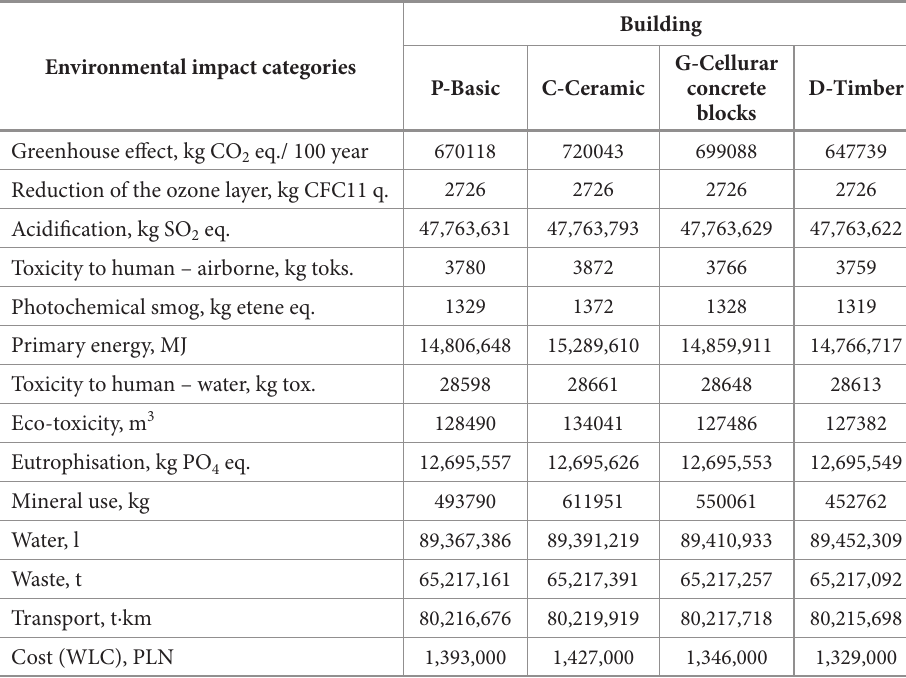
Environmental impact categories